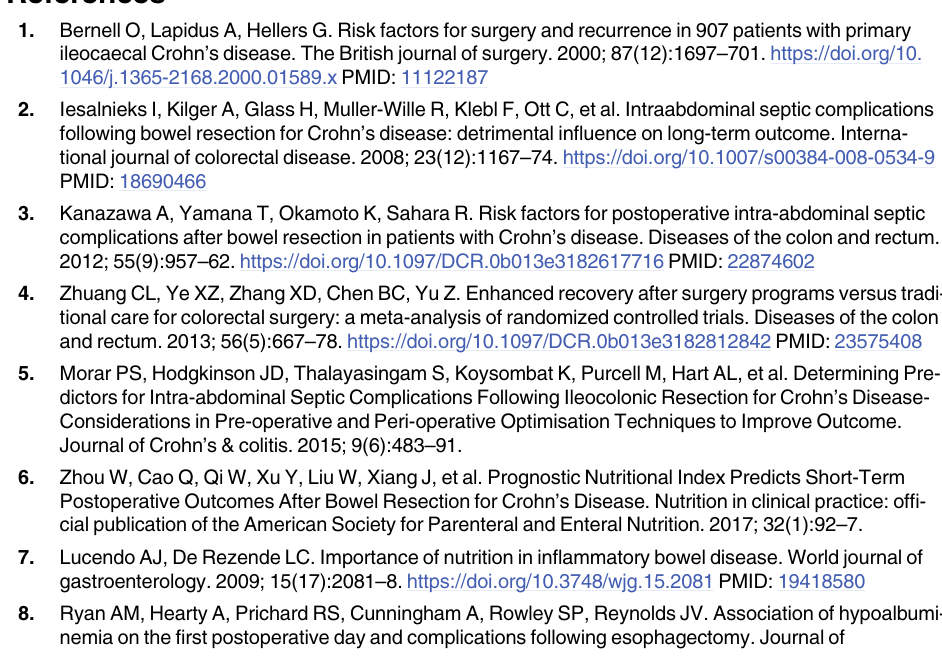
S1 Table. Data set. Raw data with anonymized basic